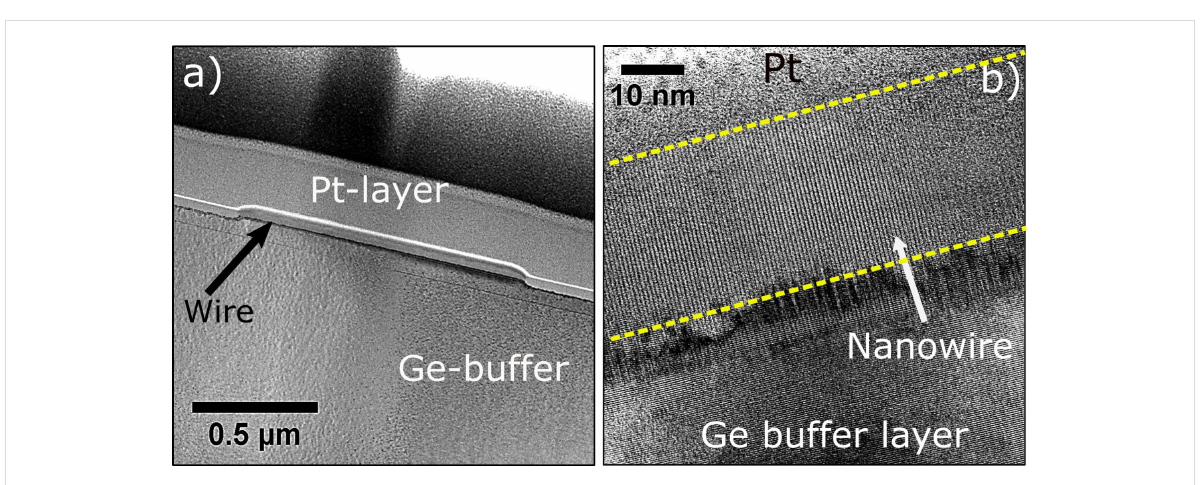
Figure 6: Cross-section image of the NW along its length. (a) TEM image of a 1.15 μ m long NW capped with a Pt layer. (b) HRTEM image along [110] zone axis. The dashed lines highlight the height of the NW of ≈ 36 nm.